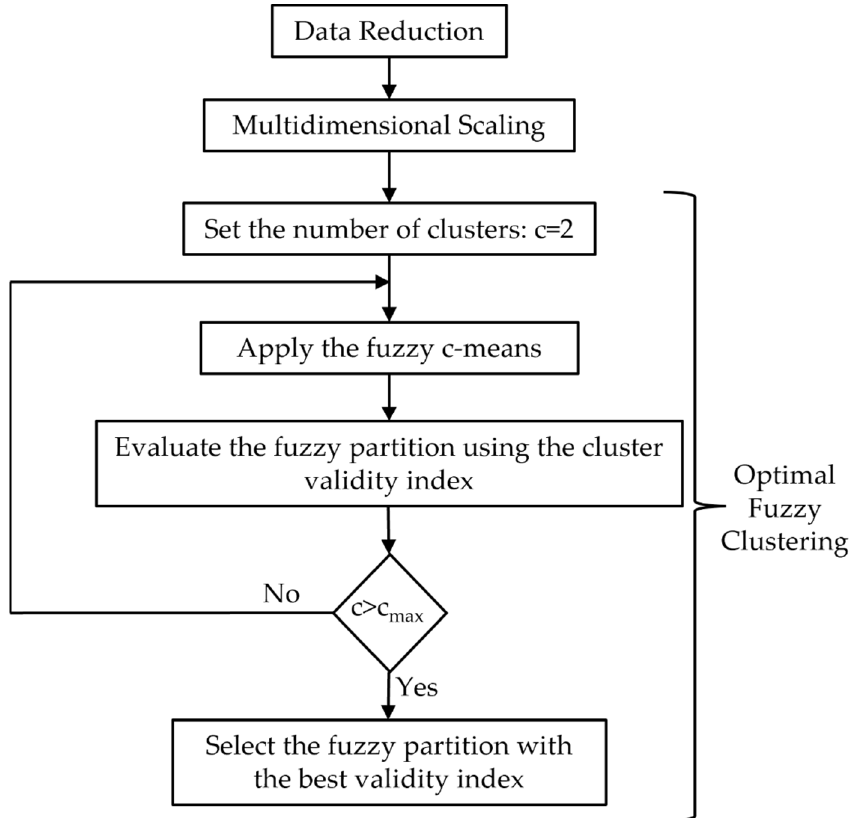
Figure 3. The basic steps of the optimal clustering algorithm: (i) the data reduction process generates several representative time series, where each time series from the original set is assigned to a representative times series; (ii) the multidimensional scaling transforms the representative time series into points within a low-dimensional feature space; (iii) the fuzzy c-means algorithm is applied several times with a different number of clusters; (iv) for each number of clusters the corresponding validity index is calculated; (v) the fuzzy partition with the minimum validity index is finally selected.